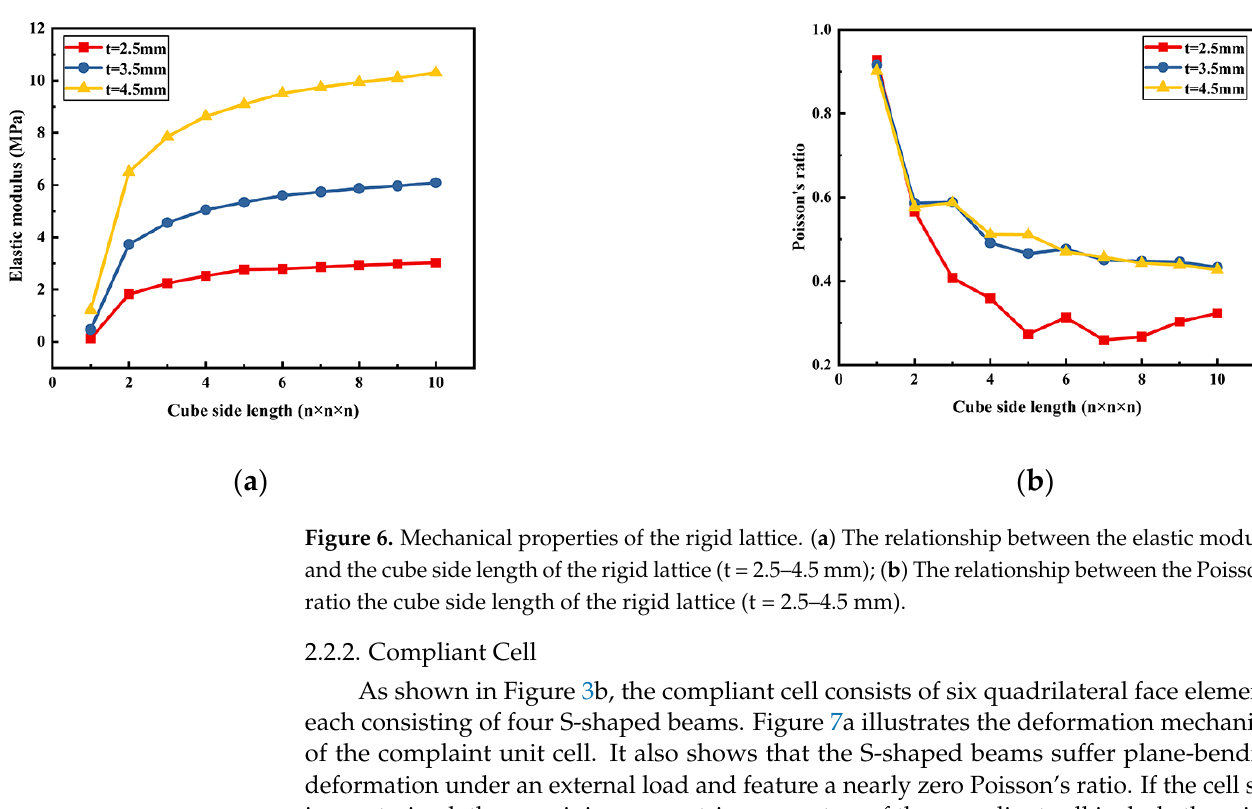
Figure 5. The deformation mechanism diagram and geometric parameter of the rigid unit cell: ( a ) Deformation mechanism of the rigid cell under an external load; ( b ) The beam section size of the rigid cell (L = 70 mm).